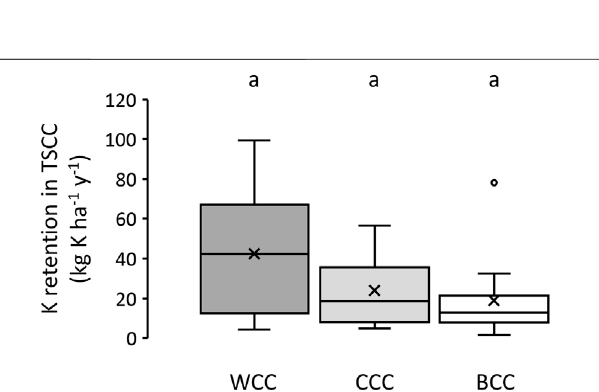
FIGURE 7 | Box and whiskers plot of nitrogen retention in the TSCC for each of the cover crop layouts. Horizontal black line, x-shaped cross, box borders and whiskers stand for the median, the mean, quartiles and outliers. Different letters over the box-plot indicate signi fi cant differences ( p < 0.05).WCC,CCCandBCCstandforolivesgroveswhereTSCCoccupiedthe wholearea,wasabsentundertreecanopyoronlyoccupiedastripoftheinter- row area, respectively.